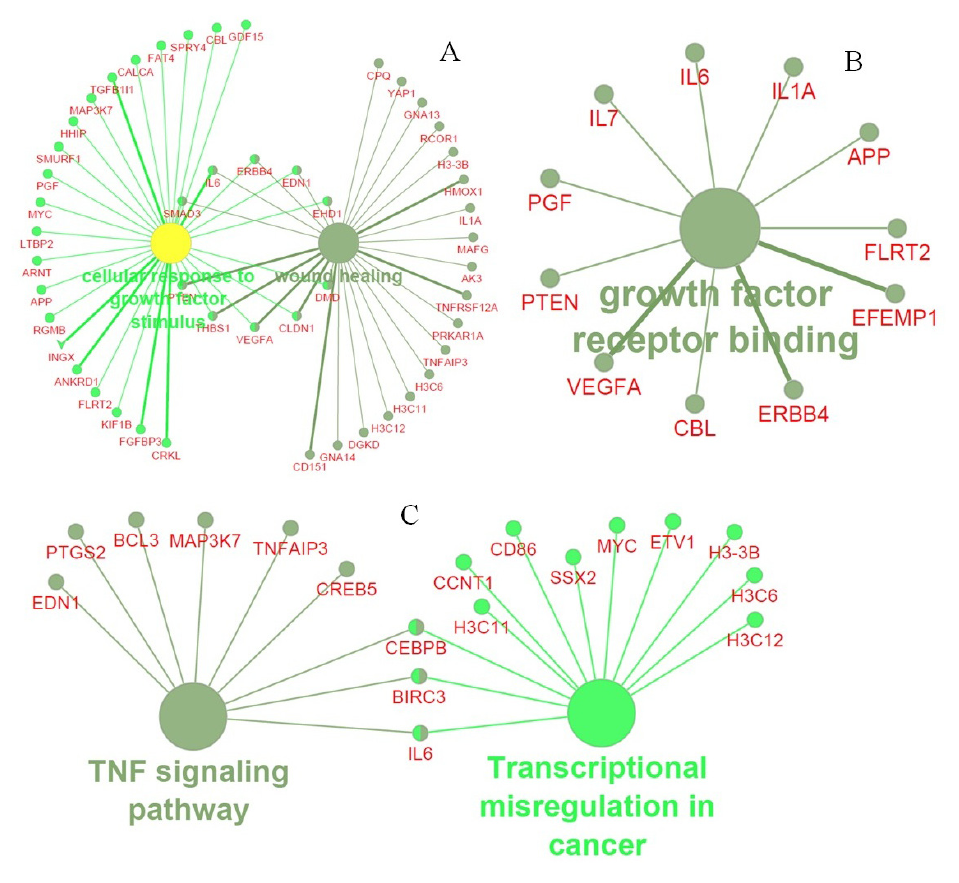
Figure 3. GO and Pathway enrichments of the PPI network. ( A ) Biological process term; ( B ) Molecular function term; ( C ) Pathway enrichment terms of PPI network.